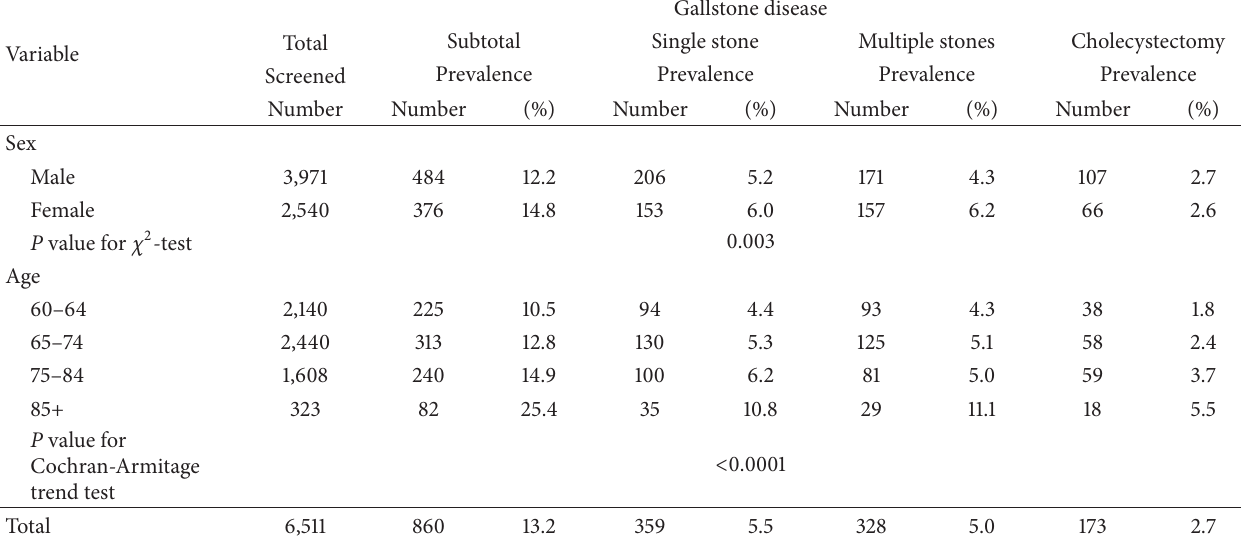
Table 1: The gender and age specific prevalence of gallstone disease among elderly agricultural and fishing screened subjects ( n = 6,511). Gallstone disease Subtotal Single stone Multiple stones Cholecystectomy Variable Prevalence Prevalence Prevalence